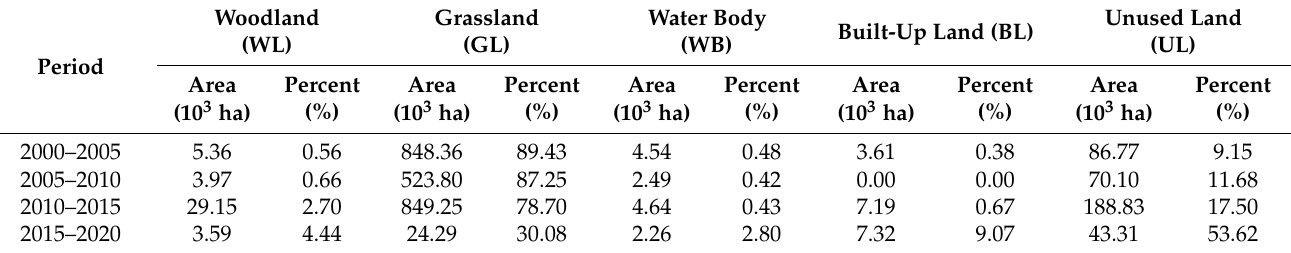
Table 6. Statistics on the sources of newly added cropland in Xinjiang during